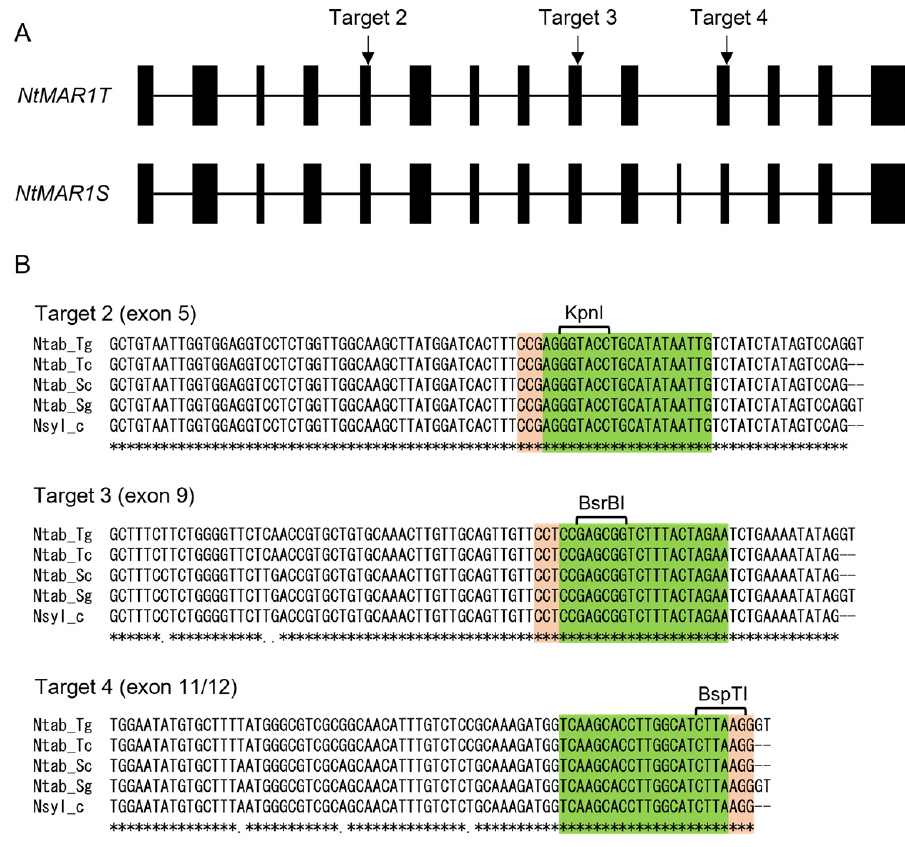
Figure 2. The genome editing targets in tobacco MAR1 / RTS3 homologs. ( A ) Scheme of tobacco MAR1 gene. Exons are shown in filled boxes (14 and 15 exons in NtMAR1T and NtMAR1S , respectively), and introns with lines (13 and 14 introns in NtMAR1T and NtMAR1S , respectively). Although the size of exons is shown in proportion to the actual sequence, intron lengths are not. Black arrows denote the location of target sequences. ( B ) Alignment of the genomic and cDNA sequences of NtMAR1T and NtMAR1S and the cDNA sequence of the Nicotiana sylvestris homolog. The PAM and target areas are colored orange and green, respectively. The restriction enzymes used for CAPS analysis and their recognition sites are shown above the alignments. Asterisks denote perfect matches within all five sequences. Dashes indicate gaps in alignments that correspond to introns.